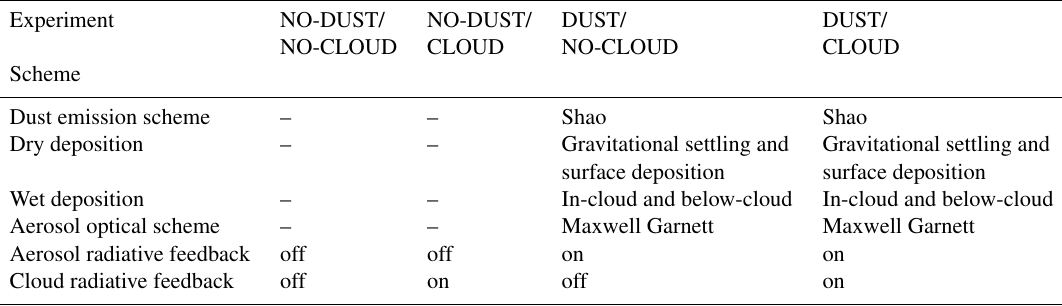
Table 1. Model configurations for the numerical